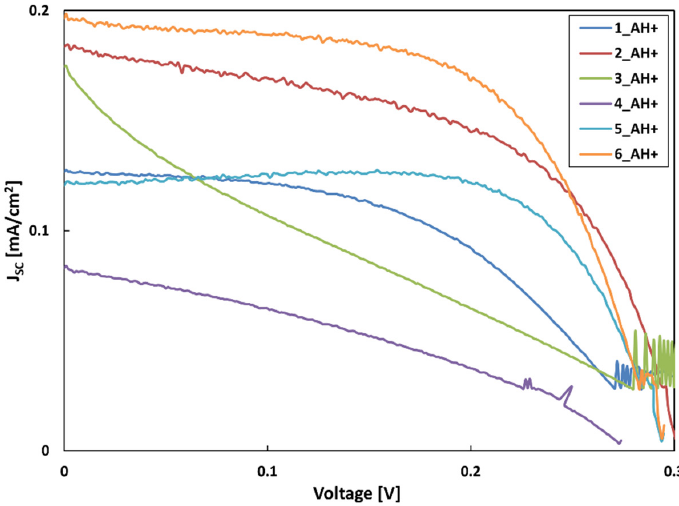
Figure 8. The J–V curves of DSSCs based on the flavylium cations AH + under 100 mW ∙ cm − 2 simu- lated AM 1.5 G illumination. simulated AM 1.5 G